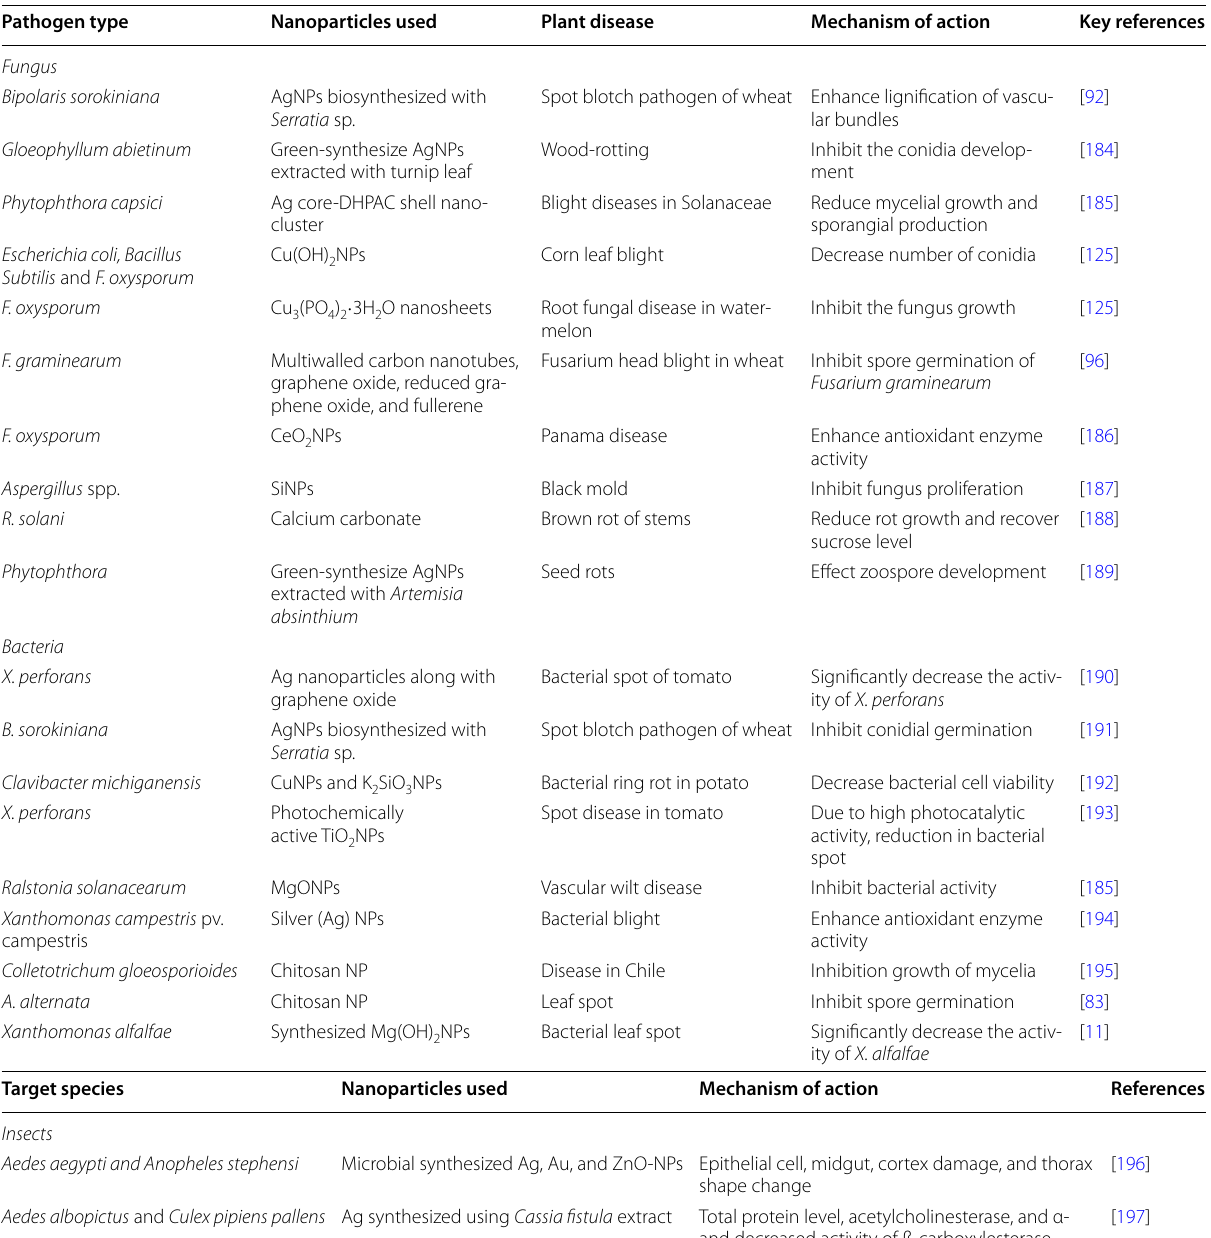
Table 2 Successful application of nanocomposites for biotic stress tolerance Pathogen